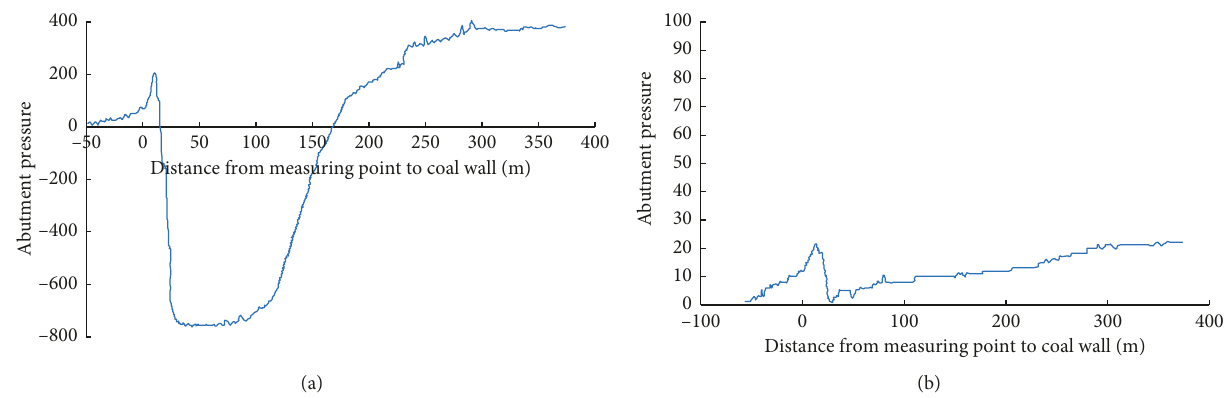
Figure 13: The changing curve of the abutment pressure in the roof as the advancement of working face at the floor strata 17m away from the open cut (in the downhill mining section). (a) Roof (located at pressure cell 13). (b) Floor (located at pressure cell 3).